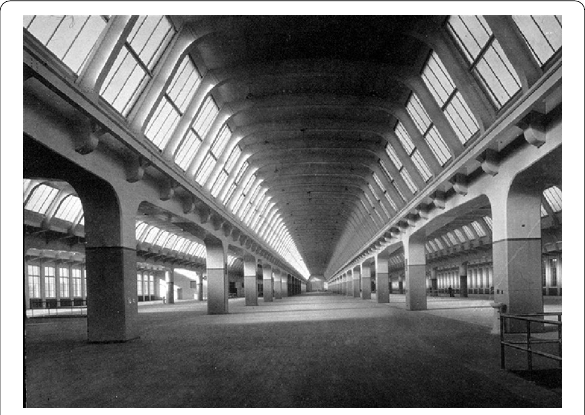
Fig. 8 Ford Engineering Lab. Dearborn, Michigan. Architect: Albert Kahn (Photo by unknown